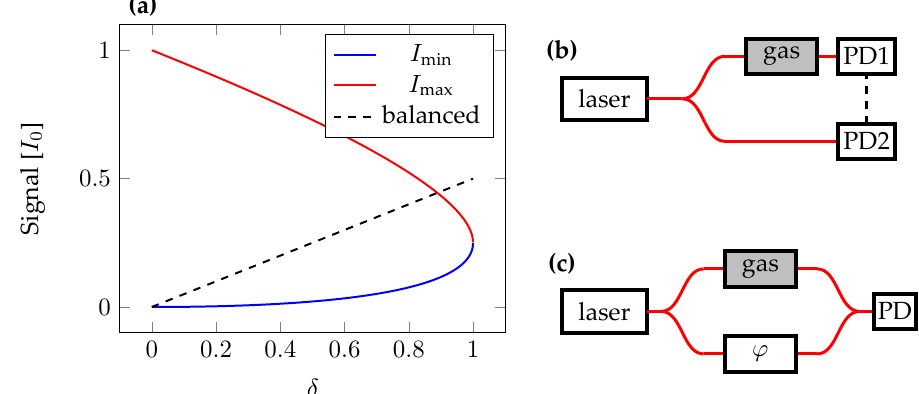
Figure 4. ( a ) The minimum intensity signal, shown in blue, from the homodyne detection is always lower than the signal that could be obtained from the balanced detection scheme, shown dashed and in black. In that regard direct homodyne measurements do not improve the sensitivity of the gas detection. The maximum intensity is plotted in red. ( b ) Schematic for a balanced detection system. The difference signal between both detectors (PD1 and PD2) is read out. ( c ) Schematic for a homodyne detection system. The interference of both arms is measured to obtain the absorption. With the phase modulator ( ϕ ) the phase can be tuned to obtain the minimum power on the photodetector